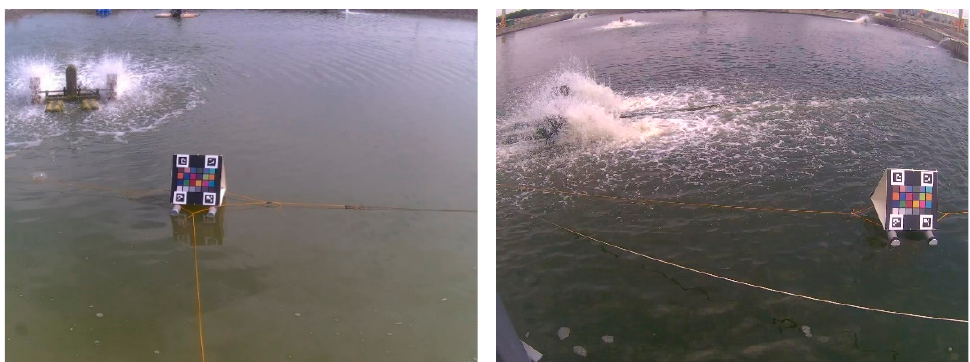
Figure 1. Our own designed color checkerboard ( a ), and the referenced ColorChecker Passport ( b ).